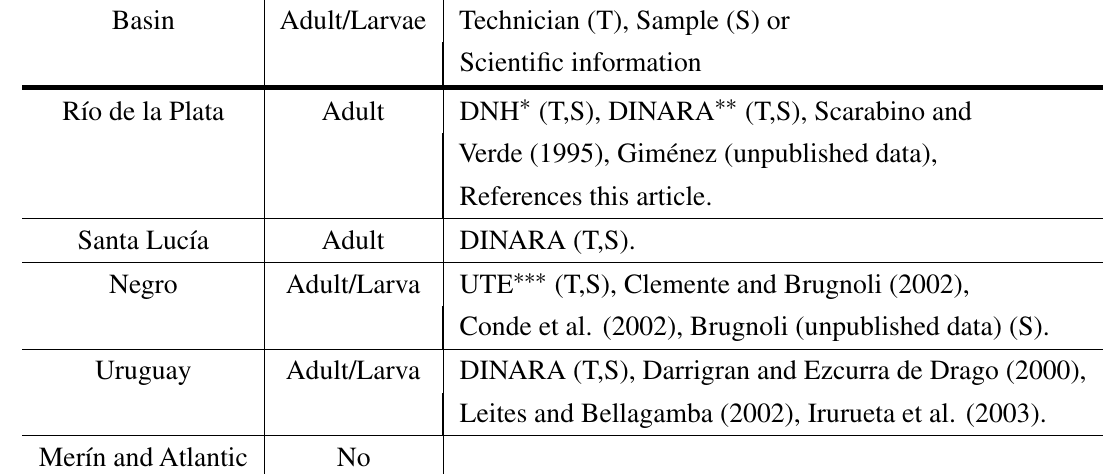
Kind of reports and samples used to construct the biologic-distributional map of Limnoperna fortunei in the Uruguayan hydrographical